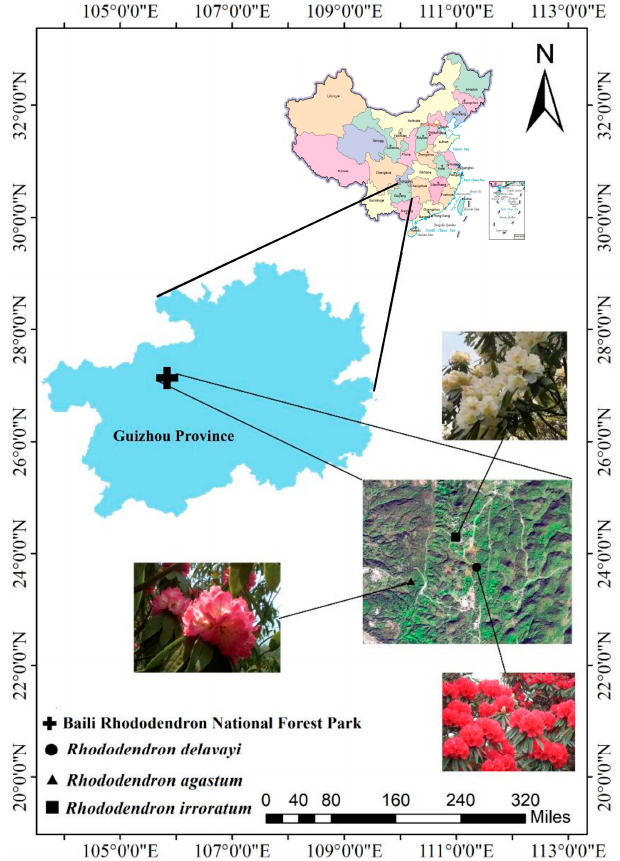
Figure 1. Distribution of the sampling points. Note: The map was drawn with reference to the Standard Map Service System (http://bzdt.ch.mnr.gov.cn/index.html (accessed on 3 December 2022), see the map number: GS (2019) 1675, Ministry of Natural Resources of the People’s Republic of China. The latitude and longitude show Guizhou Province and Baili Rhododendron National Forest